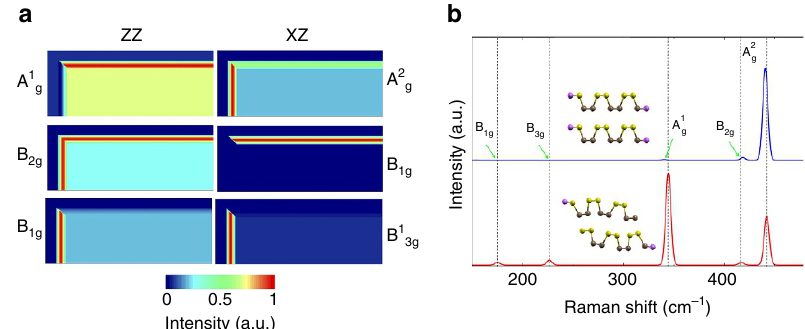
Figure 4 | Simulated Raman images and spectra. ( a ) Representative simulated Raman hyperspectral images for selected modes and scattering configurations. In each image, the top and left-hand-side regions correspond to the silicon substrate. ( b ) Unpolarized Raman spectra for an AB-stacked zigzag-terminated slab, with (red) and without (blue) edge reconstruction